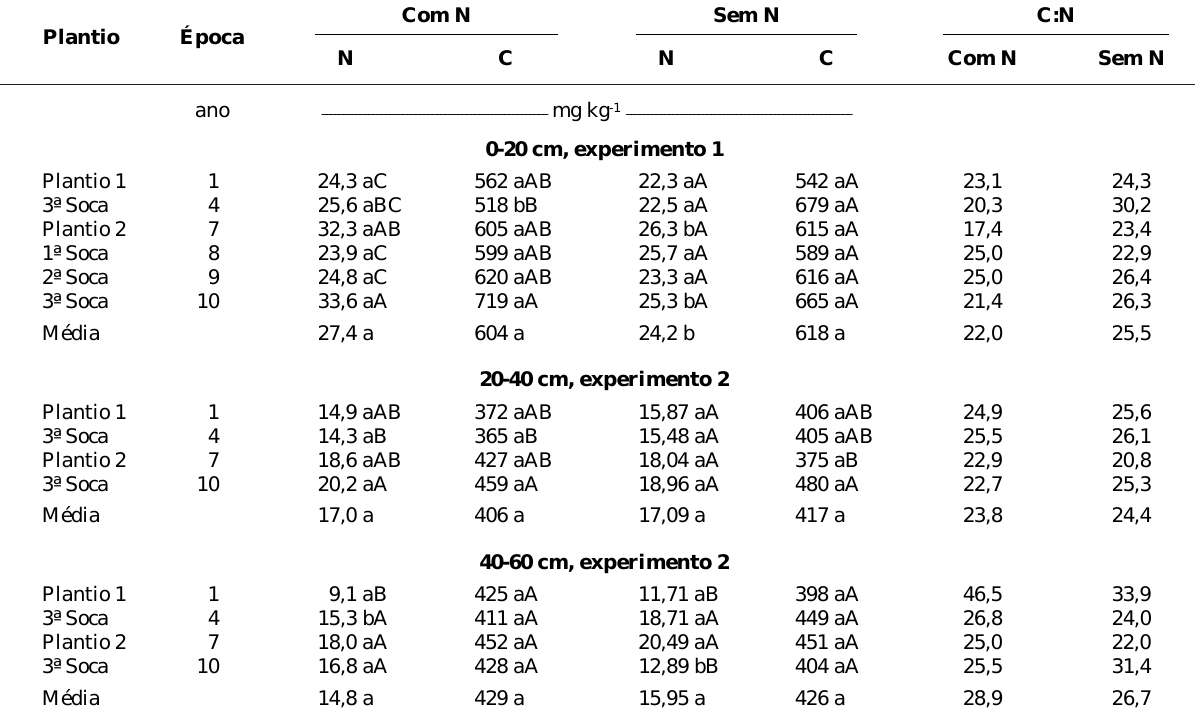
Quadro 2. Mineralização acumulada de N (NH 4+ + NO 3- ) e de C (CO ) e relação do C e N mineralizados, em 2 20 semanas de incubação, em amostras, retiradas das profundidades de 0-20, 20-40 e 40-60 cm, de um Podzólico Vermelho-Amarelo latossólico álico, em diferentes épocas após o início do cultivo com cana-de-açúcar, sem e com fertilização nitrogenada (60 kg ha -1 de N). Resultados de dois